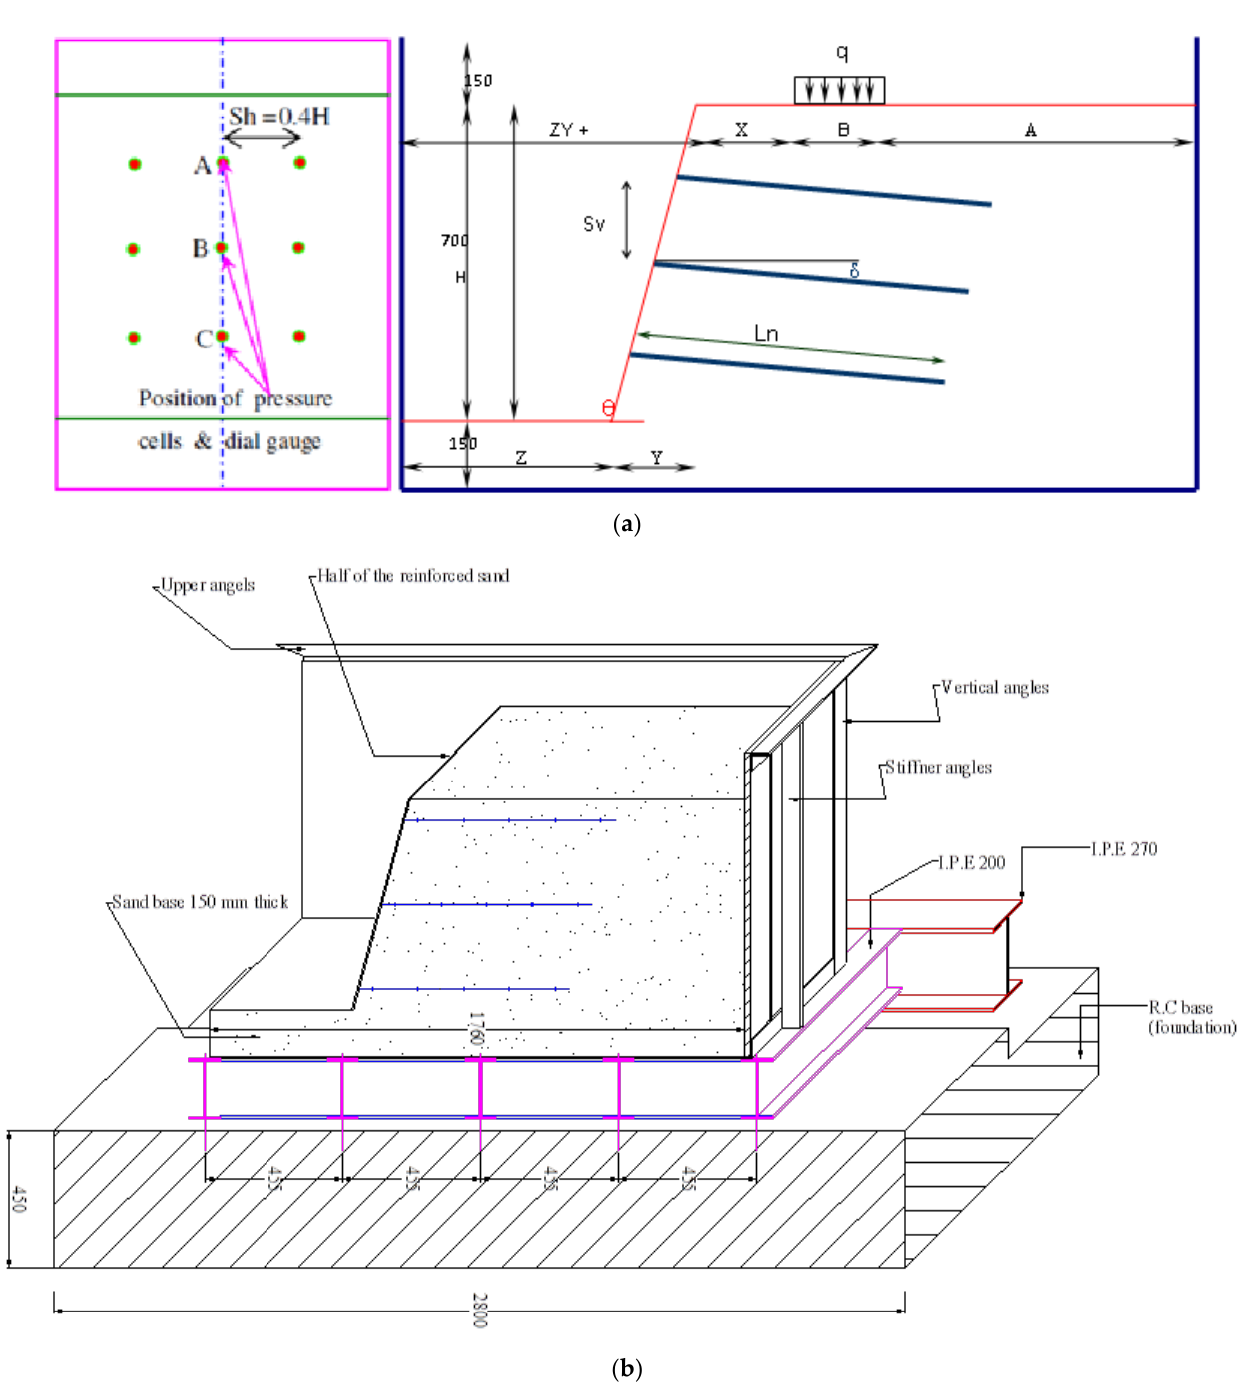
Figure 3. Laboratory model with different soil and building foundation parameters; ( a ) section and elevation of nailed soil slope model; ( b ) 3D model of nailed soil slope (all dimensions are in mm).